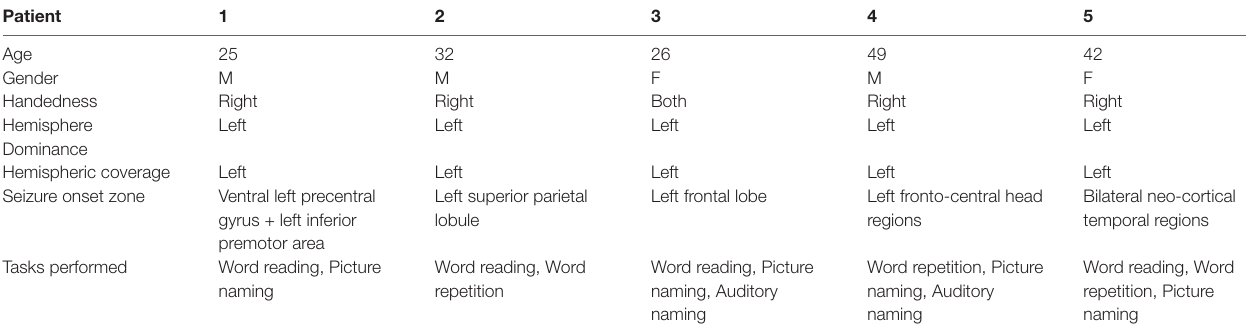
TABLE 1 | Patient demographic and clinical